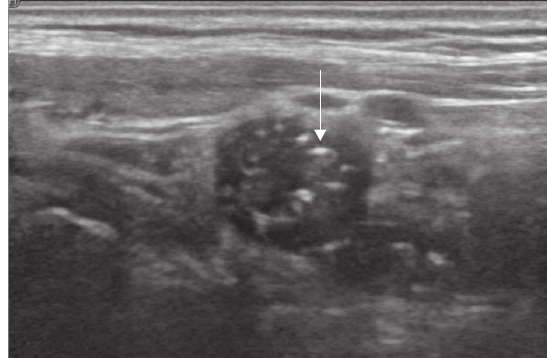
Figure 3 Punctiform strong echoes being caused by air microbubbles is presented in the